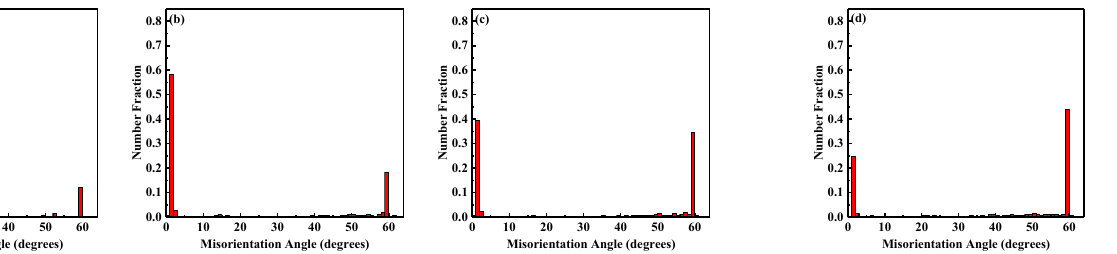
Figure 5. Misorientation of RA after different partitioning temperatures: ( a ) 280 °C, ( b ) 310 °C, ( c ) 340 °C and ( d ) 370 °C.